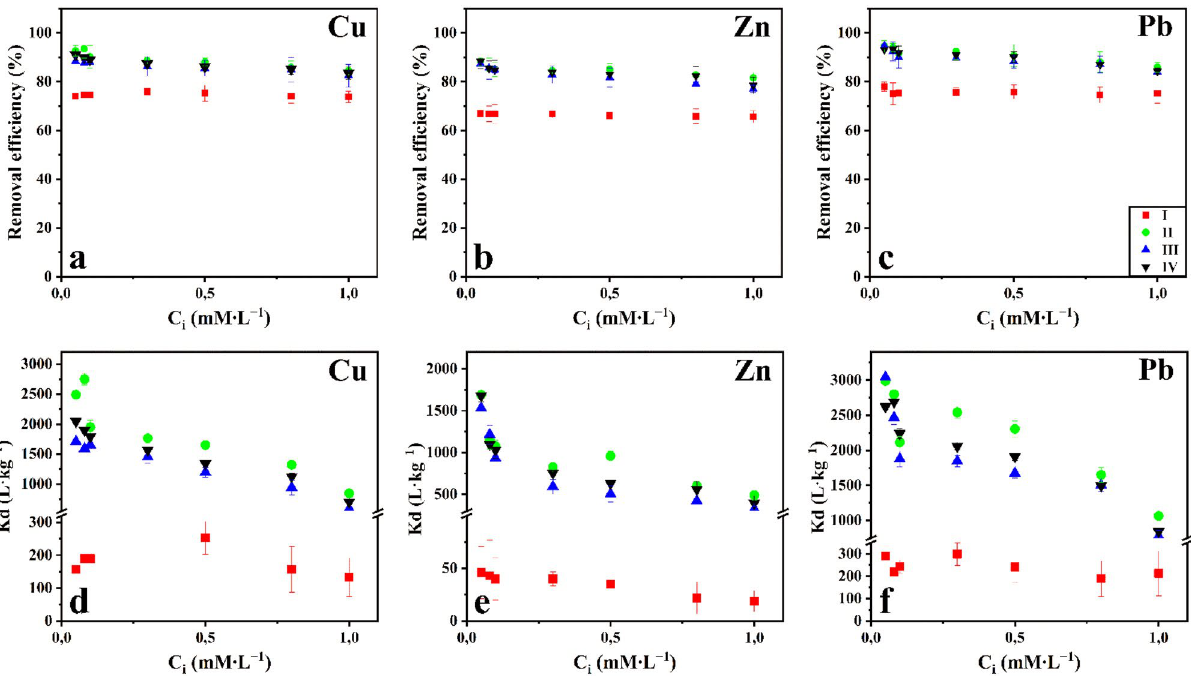
Figure 5. The equilibrium sorption coefficient ( a – c ) and removal efficiency ( d – f ) for the different variants of treatments (soil (I), soil + Wood biochar (II), soil + Sunflower husk biochar (III), soil + Rice husk biochar (IV)).